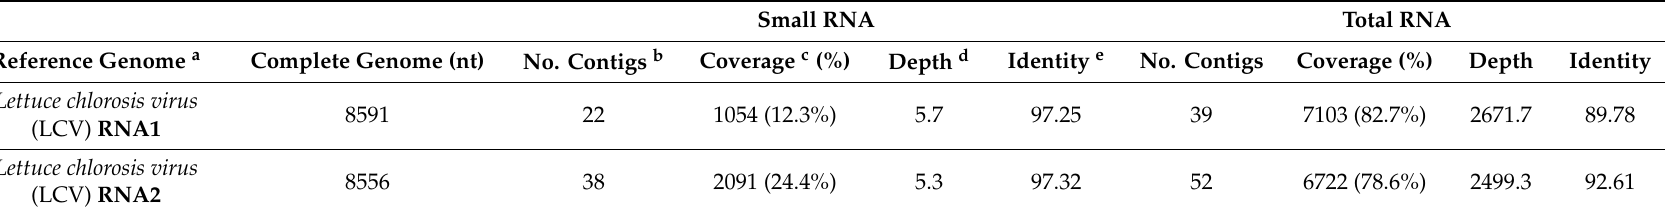
Table 1. Next generation sequencing results of constructed